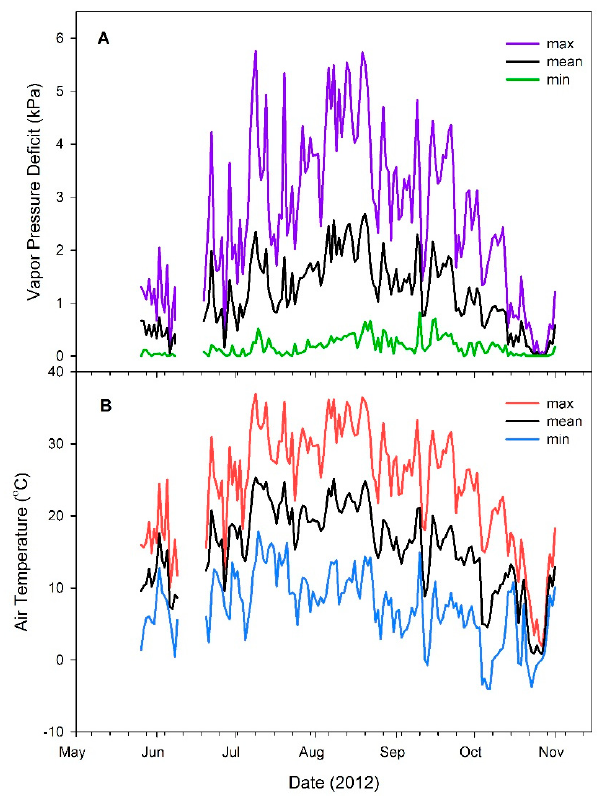
Figure 1. Daily mean, minimum, and maximum vapor pressure deficit ( A ) and air temperature ( B ) conditions during the 2012 growing season at the outplanting site on the University of Idaho Experimental Forest, Moscow, ID, USA. Data from 9–18 June are missing due to ungulate-induced weather station damage.